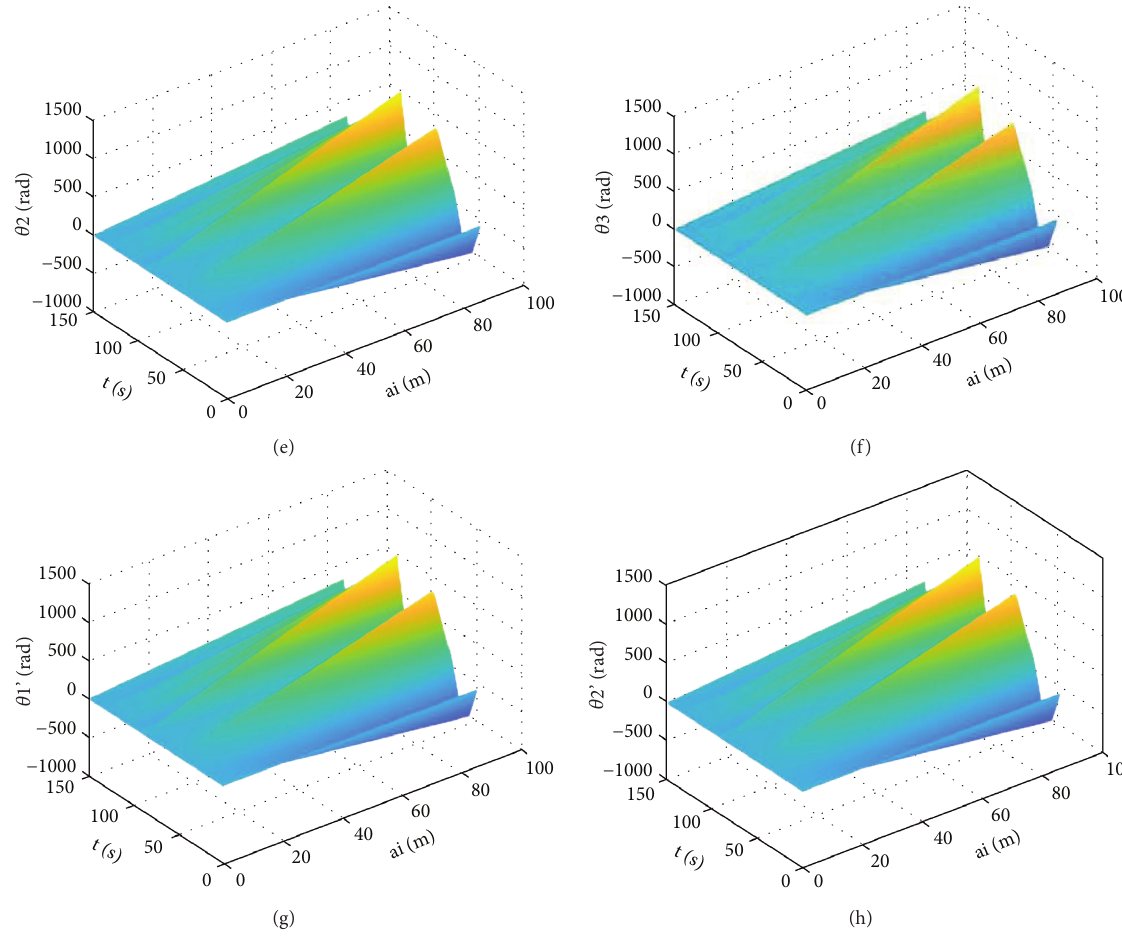
Figure 7: Surface diagrams of z ′ , and θ ′ changing with a q , z 7 , z 6 , θ 1 , θ 2 , θ 3 , θ 1 i during continuous time. (a) The surface diagram of z q changing 2 with a i . (b) The surface diagram of z 7 changing with a i . (c) The surface diagram of z 6 changing with a i . (d) The surface diagram of θ 1 changing with a i . (e) The surface diagram of θ 2 changing with a i . (f) The surface diagram of θ 3 changing with a i . (g) The surface diagram of θ ′ changing with a with a i . (h) The surface diagram of θ i 2